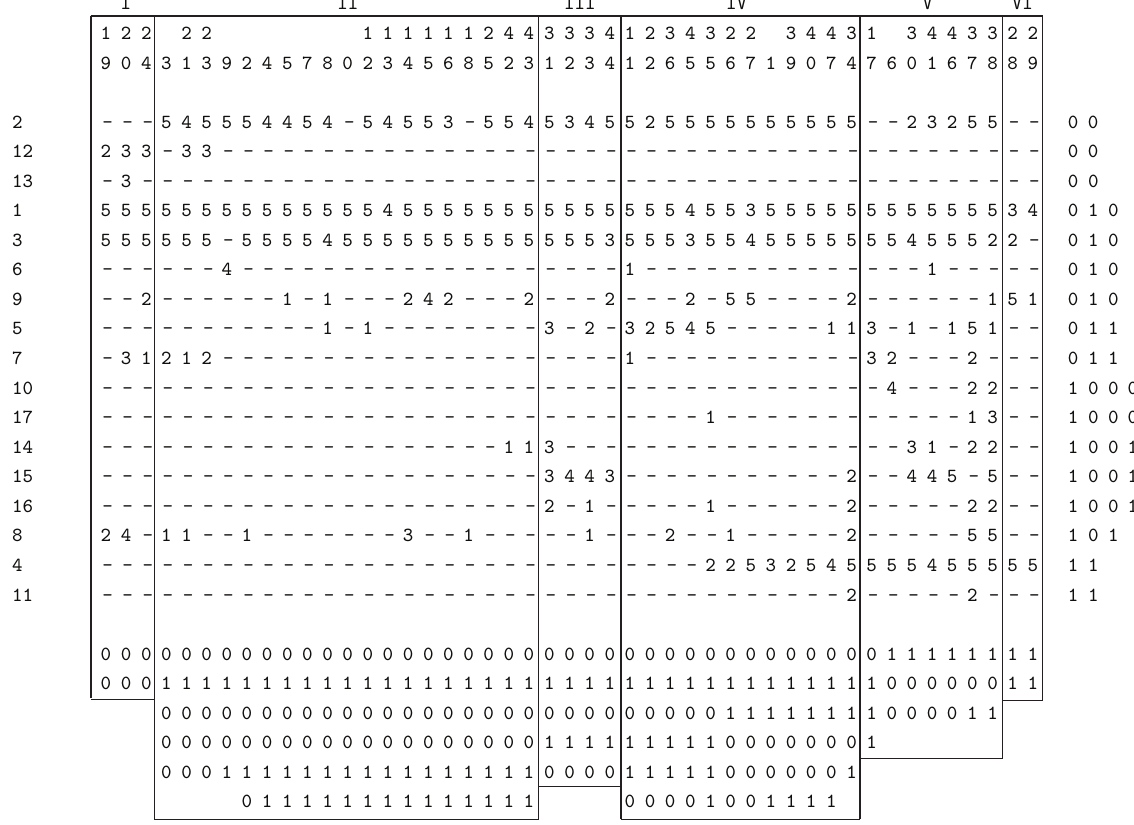
group including 2 sampling spots (S28, S29). Calamagrostis angustifolia occurred in relatively shallow water